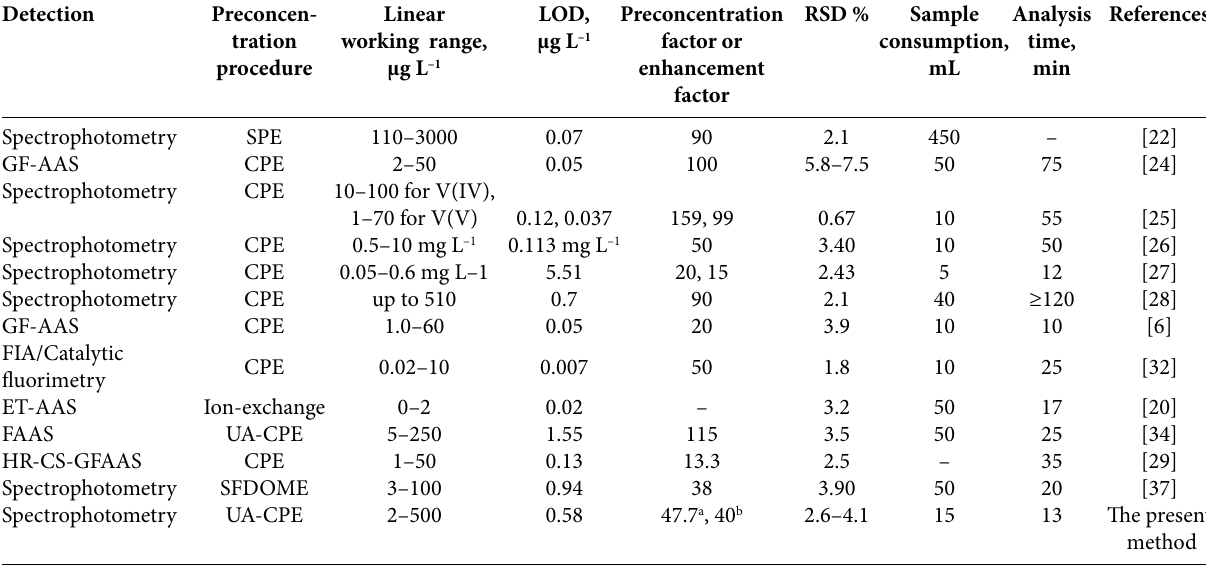
Table 5. The analytical performance data obtained by using UA-CPE coupled to spectrophotometry and other reported techniques in determination of vanadium in the selected beverage samples